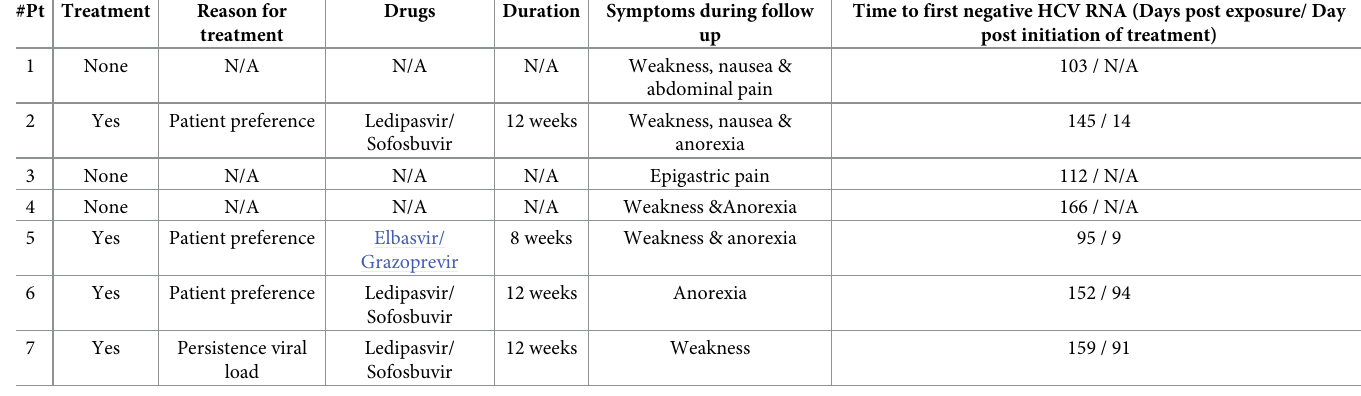
Table 4. Summary of patient